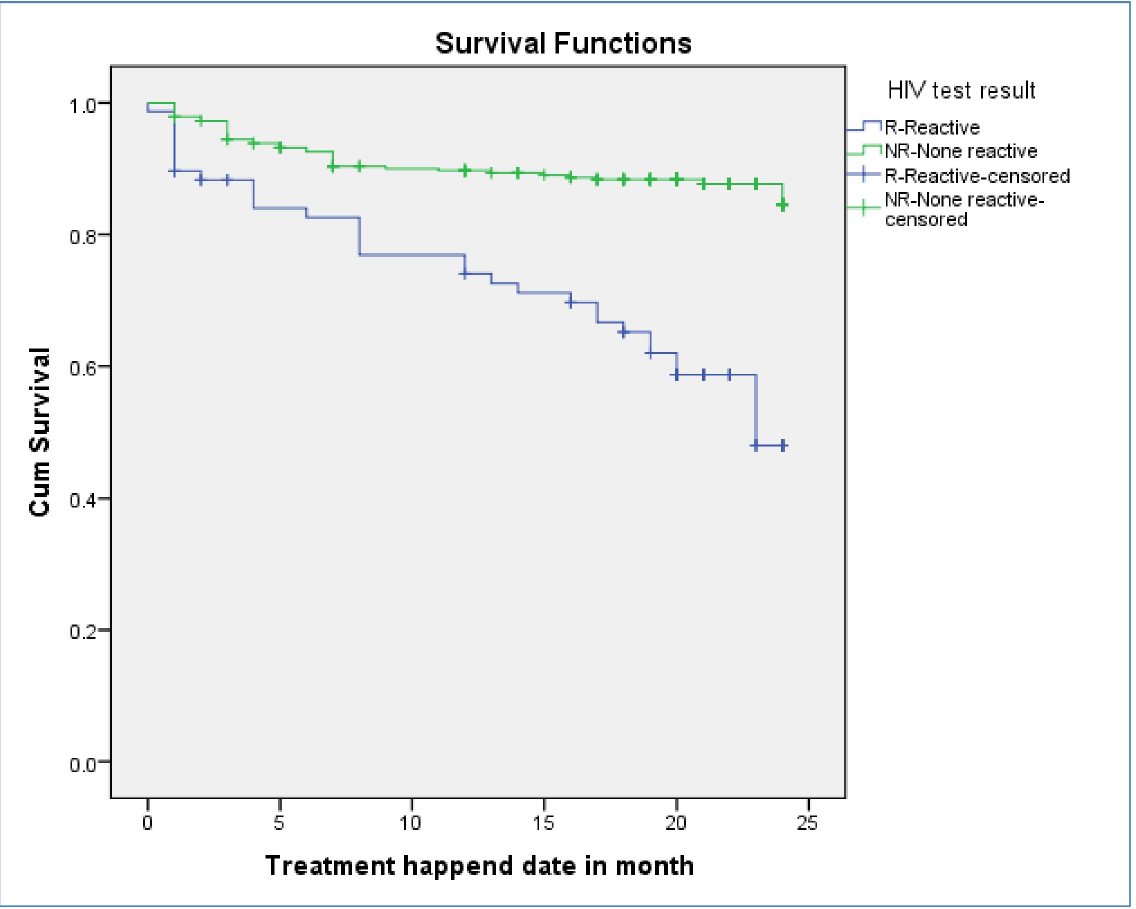
Fig 4. Kaplan–Meier survival estimate for LTF of drug resistance tuberculosis infected patents for HIV reactive and non-reactive patients in Oromia region, Ethiopia,